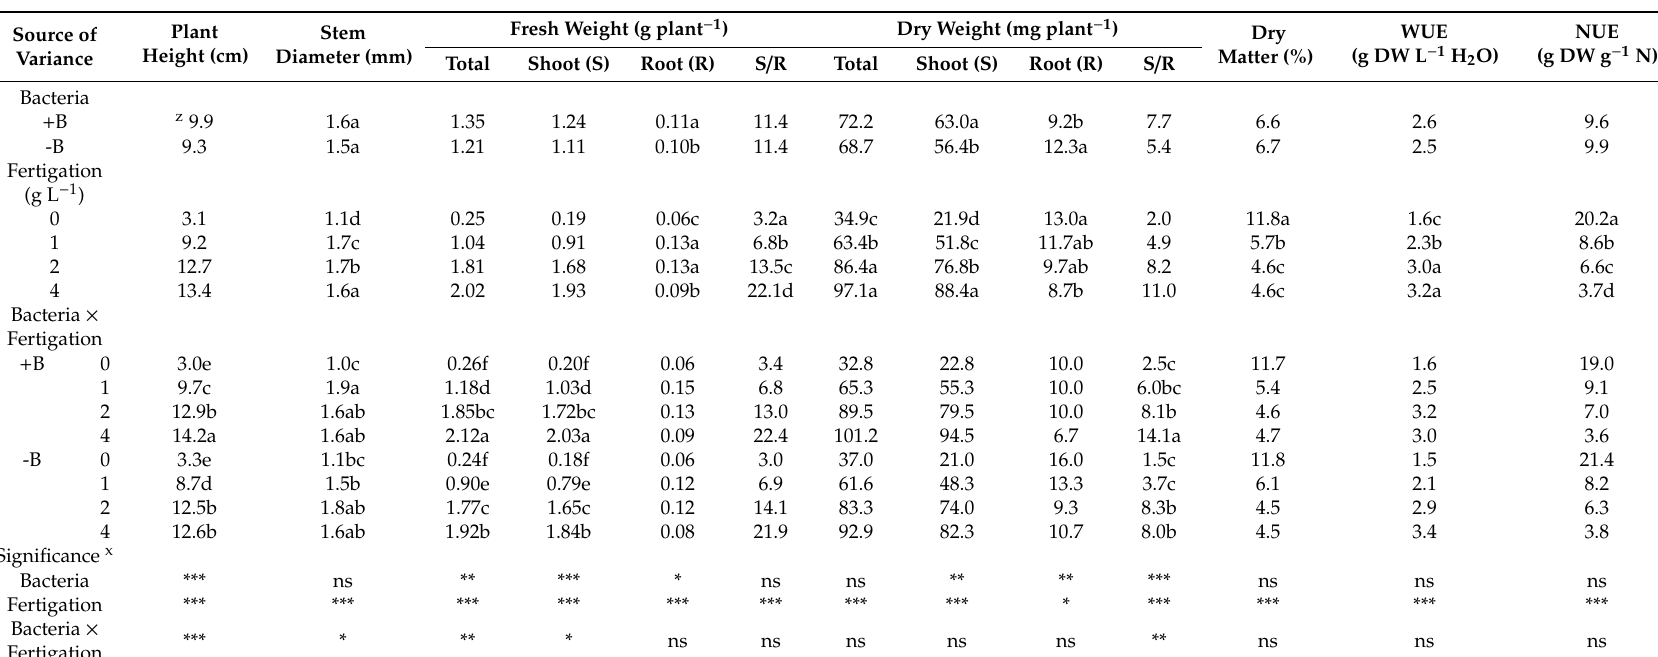
Table 1. E ff ects of the bacterial biostimulant (-B, not inoculated; + B, inoculated seedlings) and fertigation rate (g L − 1 of NPK 20-20-20) on morphological and physiological parameters of lettuce